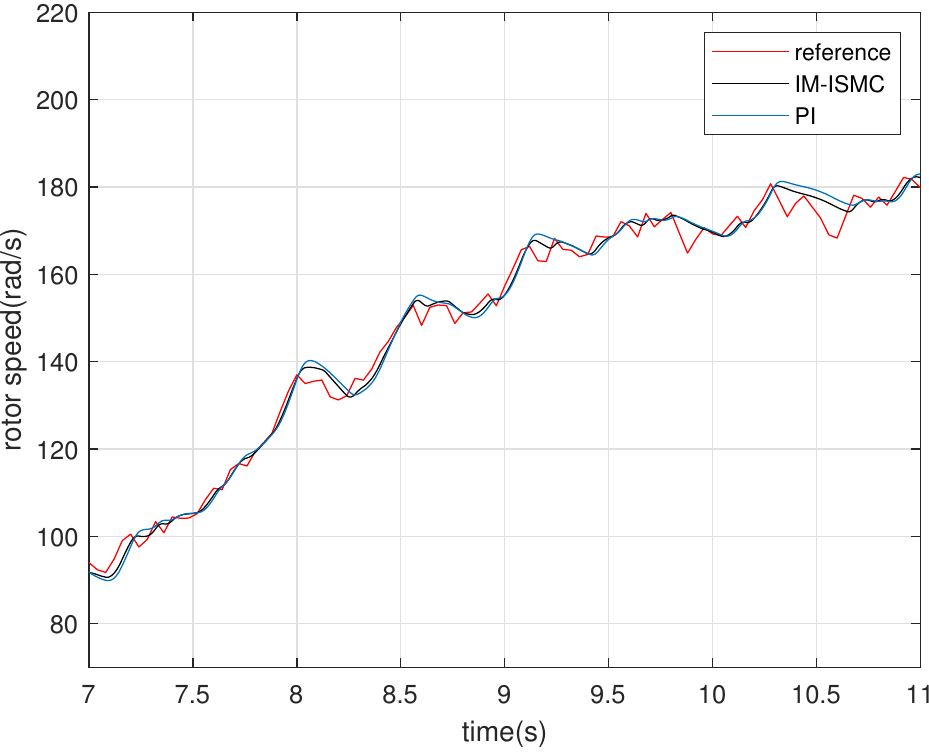
Figure 15. Rotor speed 7–11 s enlarged view.